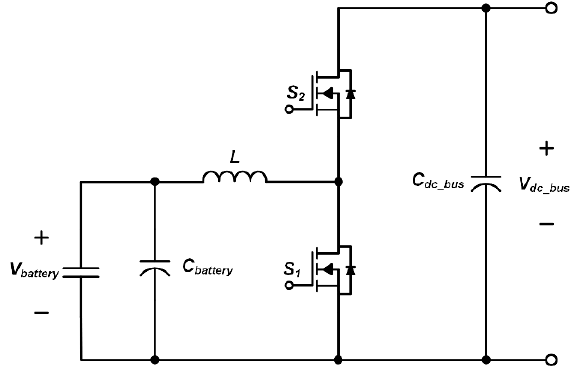
Figure 2. The topology of the half-bridge bidirectional DC–DC converter.